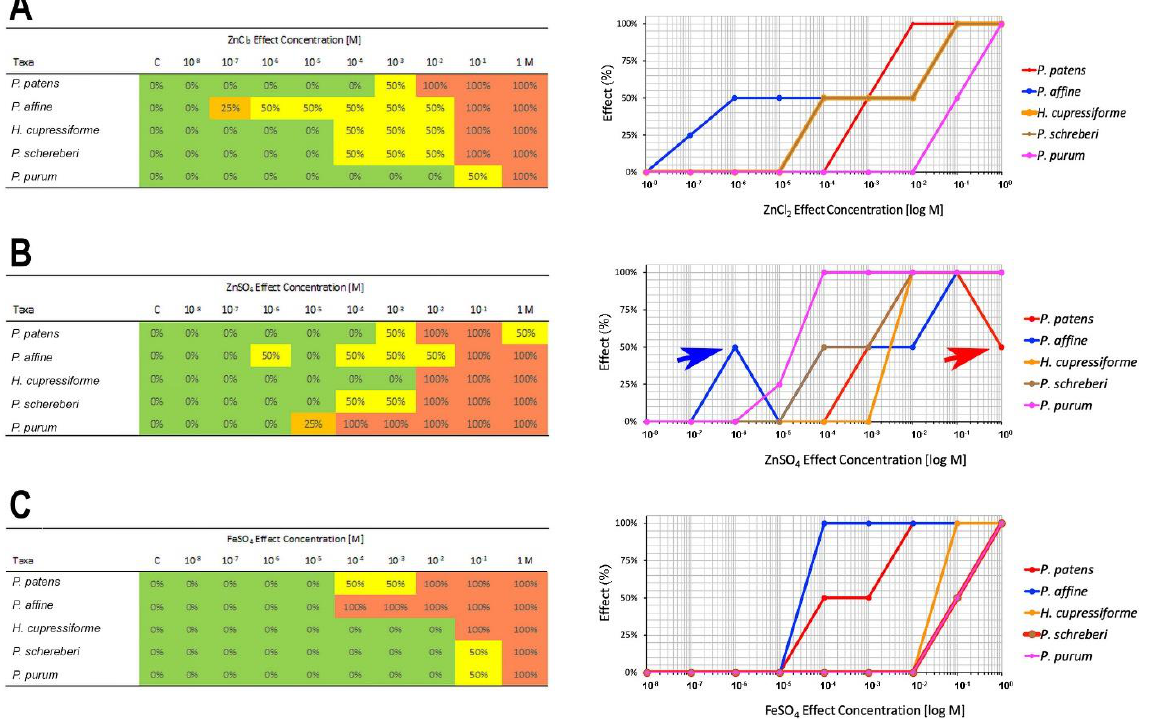
Figure 3. Percentage of dead lamina cells (0%, 25%, 50%, and 100%) and respective dose-response-curves for five moss species ( P. patens , P. affine , H. cupressiforme , P. schreberi , P. purum ) in tenfold dilution series of ( A ) ZnCl 2 , ( B ) ZnSO 4 and ( C ) FeSO 4 . The arrows in B point to possible “death zones”; blue arrow: P. affine ; red arrow: P. patens . Table 2. Median of no effect concentration (NOEC) and lowest observed effect concentration